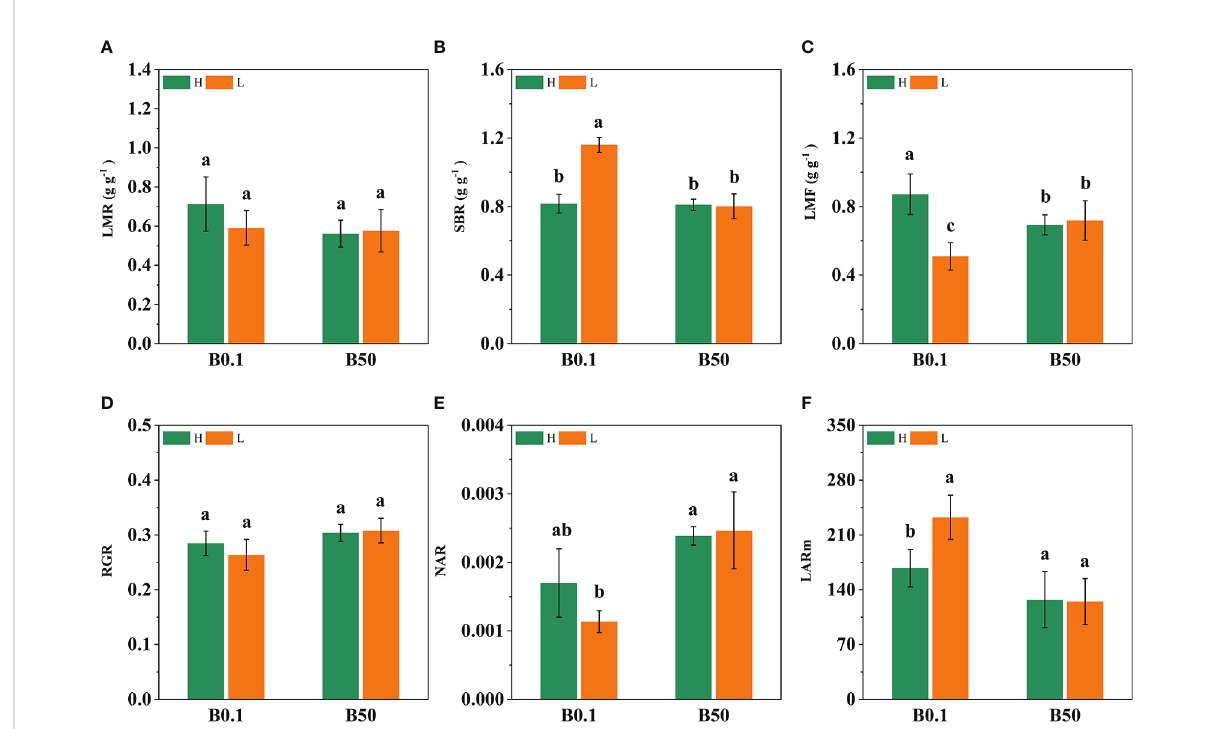
FIGURE 1 Effect of different B levels on growth paraments of two contrasting sugar beet cultivars (B-ef fi cient: KWS1197(H) and B-inef fi cient: KWS0143 (L) cultivar). LMR is leaf mass ratio (A) . SBR is supporting organ biomass ratio (B) . LMF is leaf mass fraction (C) . RGR is relative growth ratio (D) . NAR is net assimilation ratio (E) . LARm is mean leaf area ratio (F) . Different letters (a, b, c) within a column represent signi fi cant differences at P <0.05. The seedlings were treated with B de fi cient (0.1 m M H 3 BO 3 , B0.1) and B suf fi cient (50 m M H 3 BO 3 ,